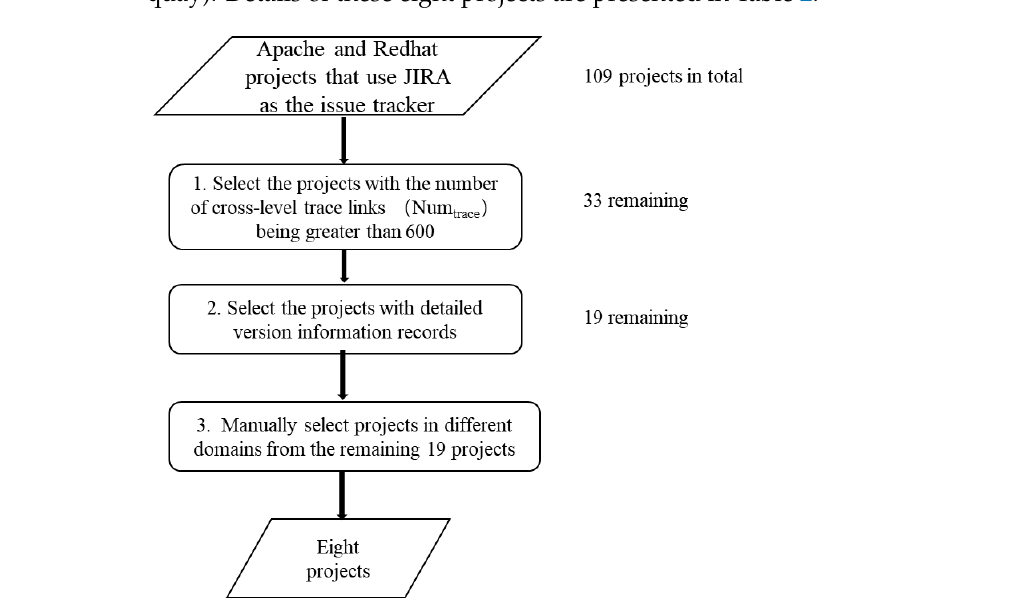
Figure 8. Flowchart of selecting projects for this study. Table 2. Details of selected projects.